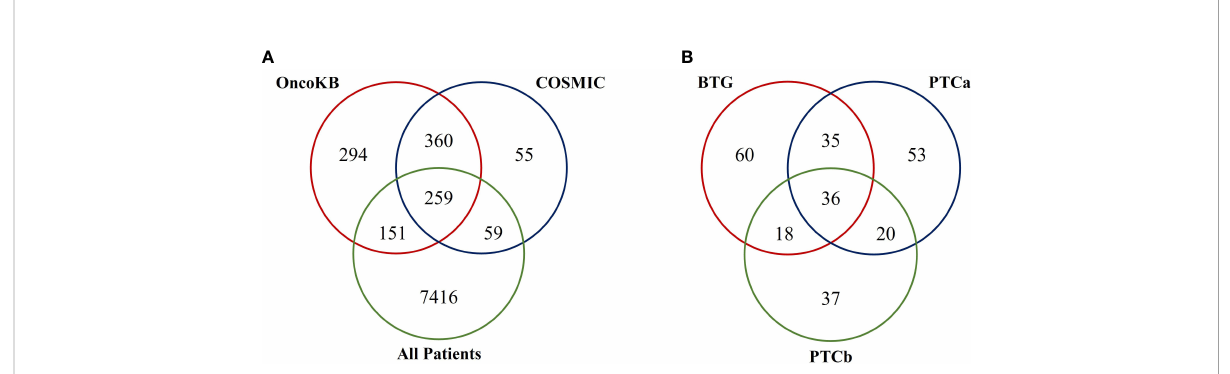
FIGURE 2 Venn diagrams illustrating fi ndings from the database search of mutated tumour-related genes in this cohort of patients. (A) A total of 259 mutated tumour-related genes were listed in both the OncoKB and COSMIC databases. (B) Among the 259 mutated tumour-related genes, there were 36 genes found to be mutated in all three disease